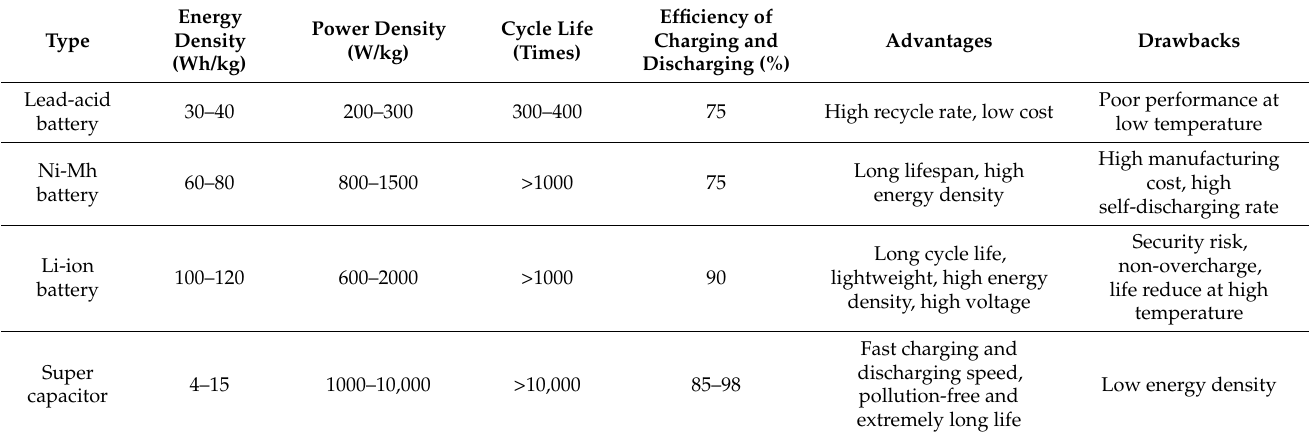
Table 3. Comparison between batteries and super capacitor